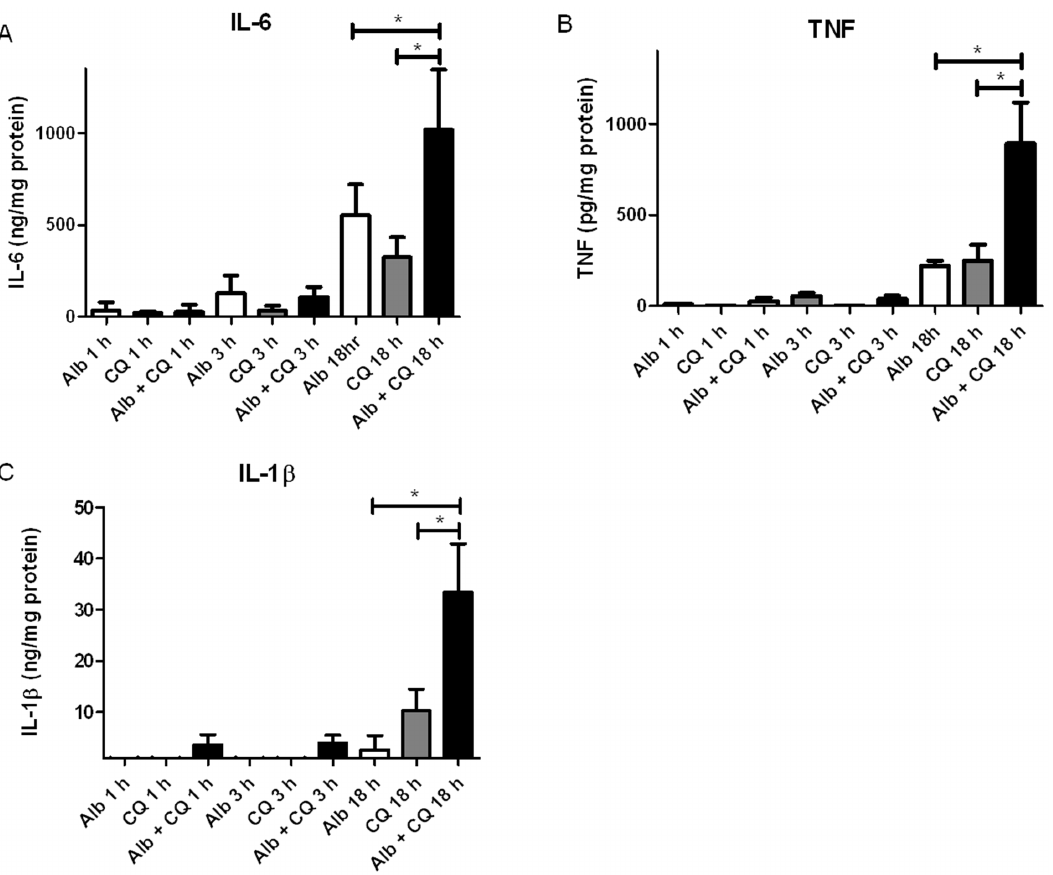
Figure 5. Chloroquine potentiated the effect of albumin on increased cytokine release in podocytes. Amount of A ) IL-6, B ) TNF, and C ) IL-1 b released into the medium after exposure to 5 mg/mL albumin (white bars), 50 m M chloroquine (grey bars) and 5 mg/mL albumin plus 50 m M chloroquine (black bars). IL-6 (n=4), TNF (n=4), and IL-1 b (n=3)were increased in podocytes exposed to both albumin and chloroquine compared to either exposure alone at 18 hrs, *p , 0.0001.